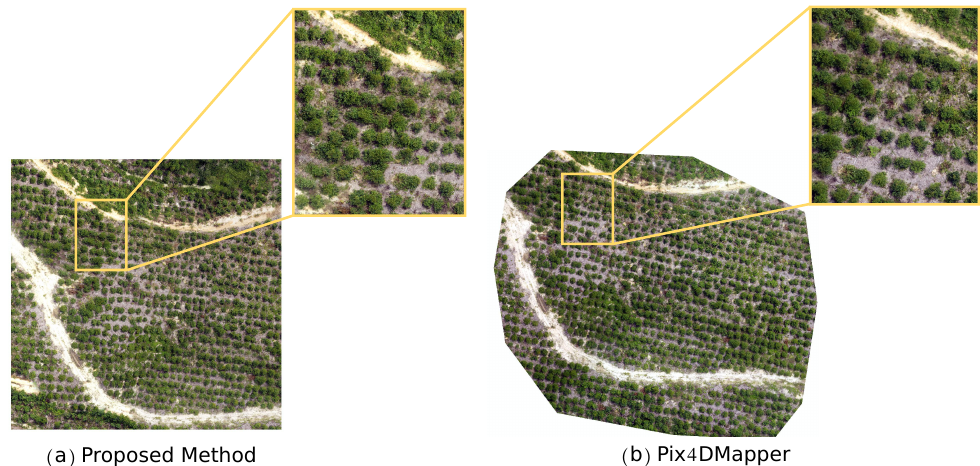
Figure 4. Mosaic results of the proposed method on acacia dataset. Some screenshots are highlighted to demonstrate the mosaic details. Our stitching quality is generally high compared with the offline results of state-of-the-art commercial software